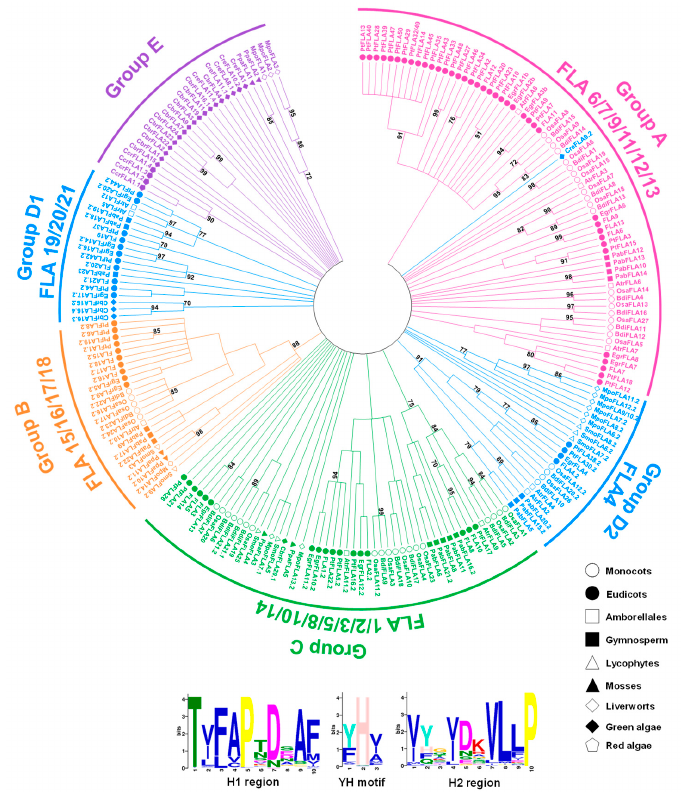
Figure 3. Phylogenetic relationships between Type 2 fasciclin domains in plant species. The amino acid sequences of fasciclin domains in FLAs were aligned by Clustal Omega 1.2.2 with the guide of HMM profile of fasciclin domains, and the phylogenetic trees were built by Mega 7 using the Maximum Likelihood (ML) method with 85% partial deletion. Bootstrap analyses with 1000 replicates were performed for support estimation. The confidence values below 50% were cut off, and the confidence values higher than 70% are shown on nodes. The tree was divided into six major clades: Group A, Group B, Group C, Group D1, Group D2, and Group E. Plant species from different lineages are shown in different shape. FLAs from A. thaliana are indicated for each clade. The domain closest to the N-terminus is indicated by .1 and the second by .2. The conserved motifs (H1, H2, and YH motifs) shown below the tree were found using the MEME web server.